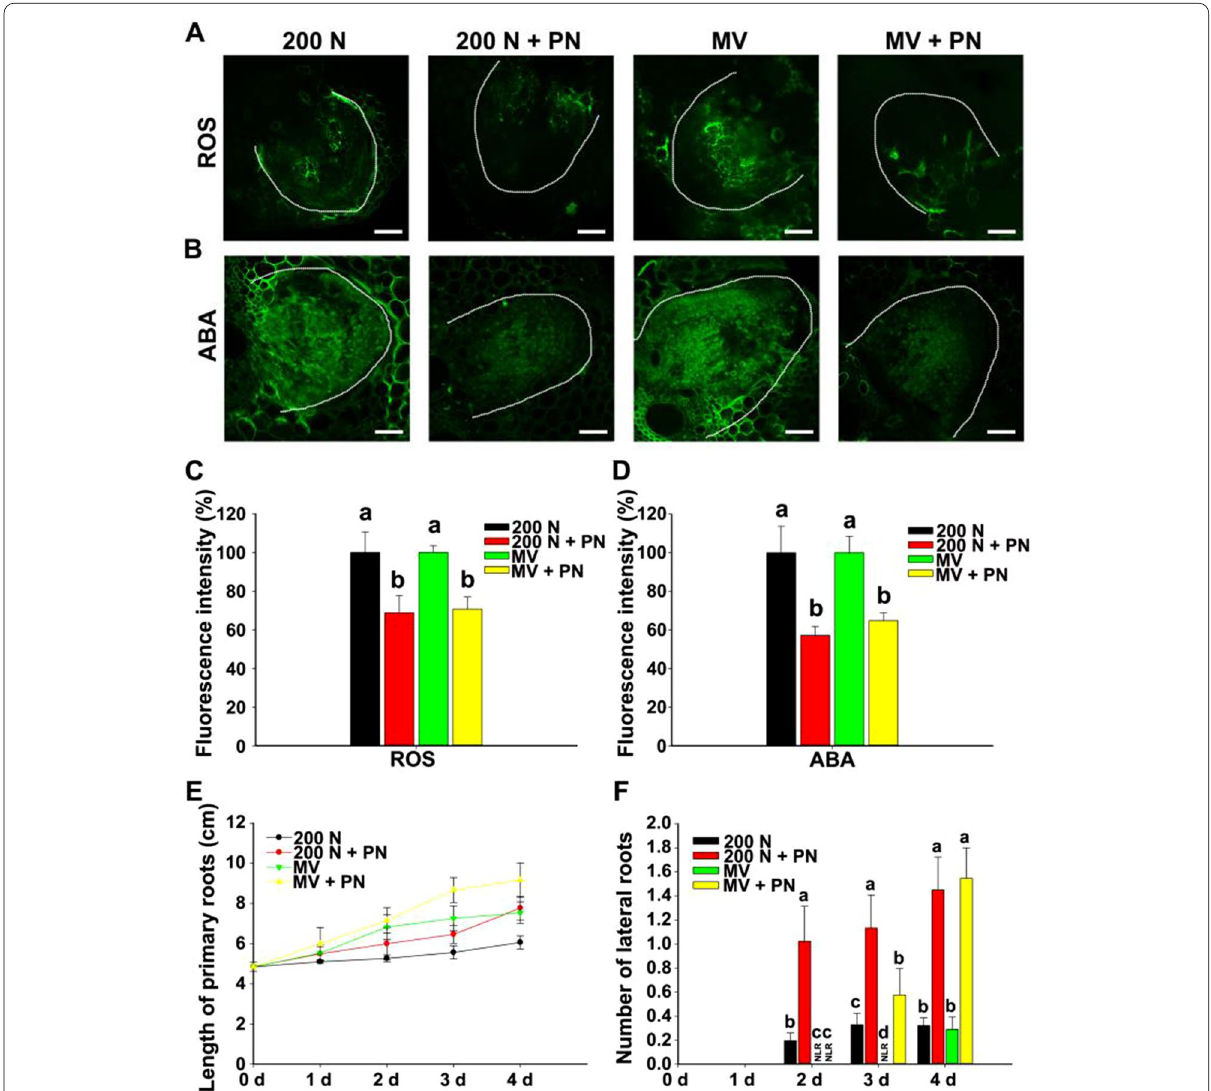
Fig. 3 Exogenous PN reduced ROS and ABA accumulation under salt stress. A , B ROS and ABA fluorescence in LRs of 6-d-old seedlings subjected to 200 mM NaCl (N), 200 mM